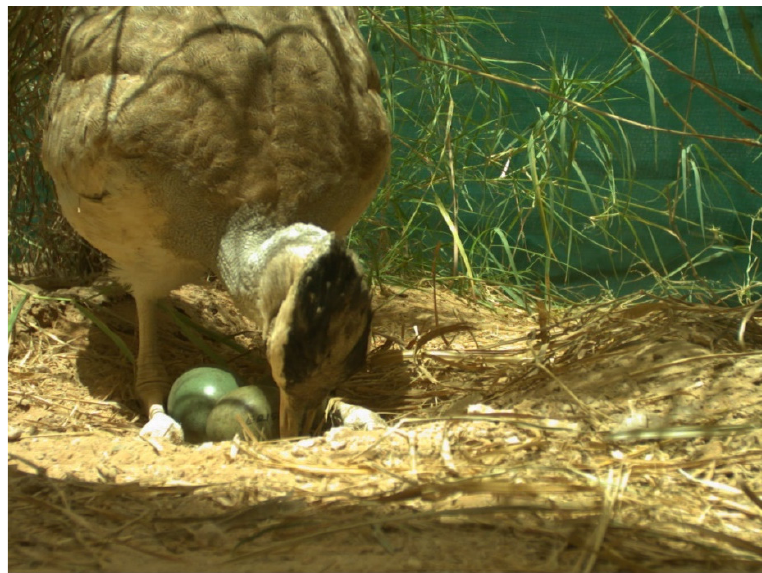
Figure A1. Captive female Arabian bustard turning eggs at the nest.